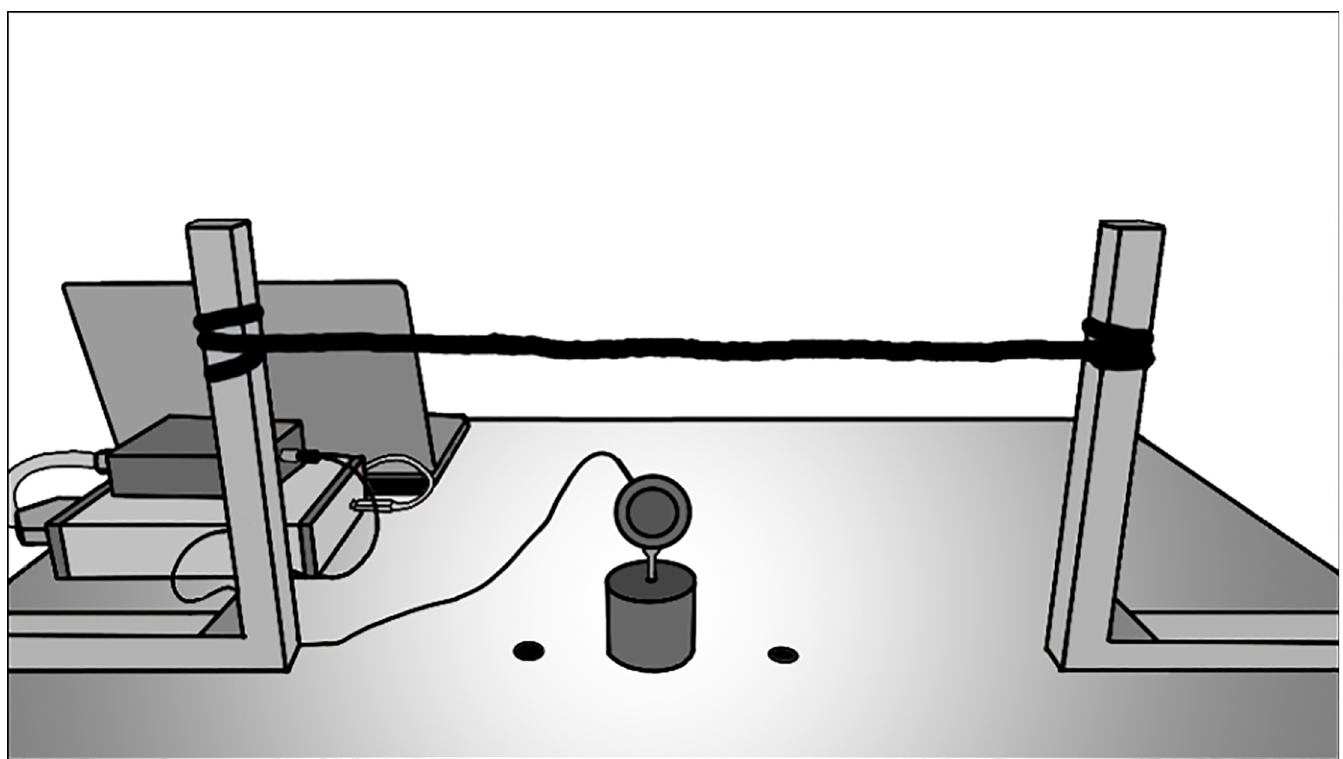
Fig 1. Set up of size weight illusion. Participants placed their hands on the black markers. Participants lifted the object by the handle in both conditions until it reached the ribbon. Here they held the object steady for 5 seconds. In the visual condition participants were only allowed to look at the object before lifting it by the handle. In the haptic condition participants were blindfolded and were allowed to feel the object with their left hand. They were then asked to place the left hand back on the black marker and lift the object with their right hand by the handle.